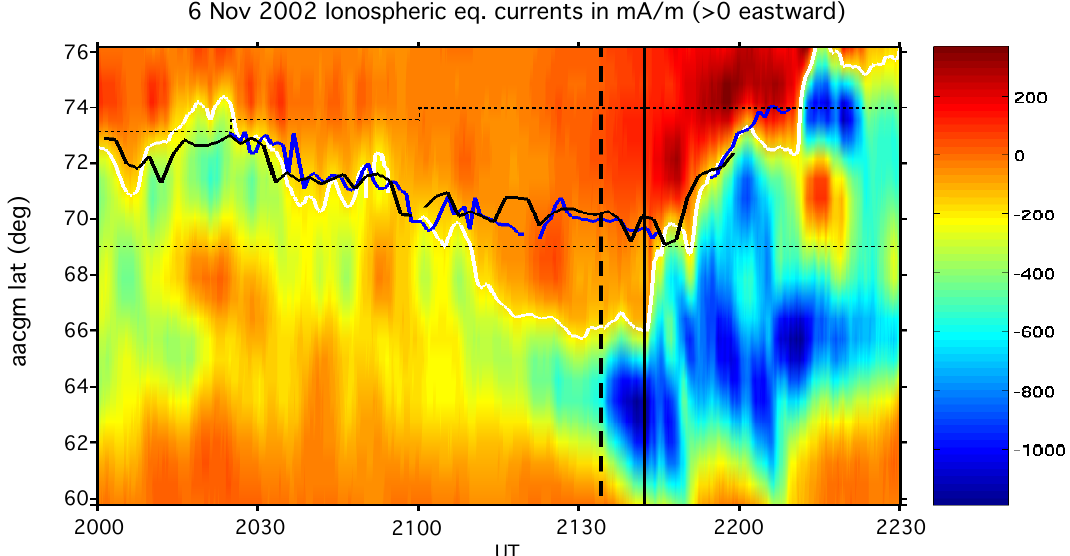
Fig. 7. Equivalent east-west current over a large latitude range as a function of time. The white line indicates the poleward boundary of the WEJ (–200mA/m). The polar cap boundary from ESR 32m (black line) and VHF (blue line) are added. The vertical (solid) dashed line indicates onset of a pseudobreakup at 21:34 UT (substorm onset at 21:42 UT). The horizontal dotted lines indicate the latitude range, where the PCB in this event can be located using the radar data.